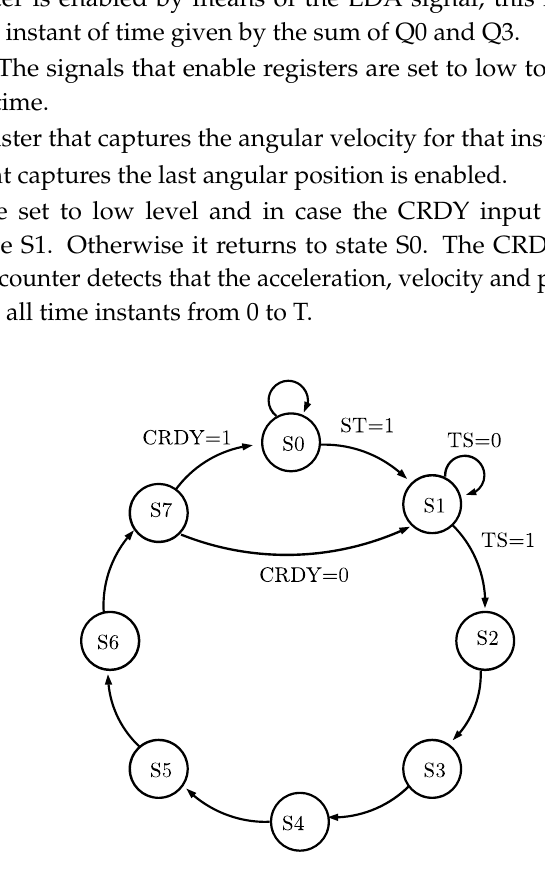
Figure A2. Discrete trapezoidal profile state